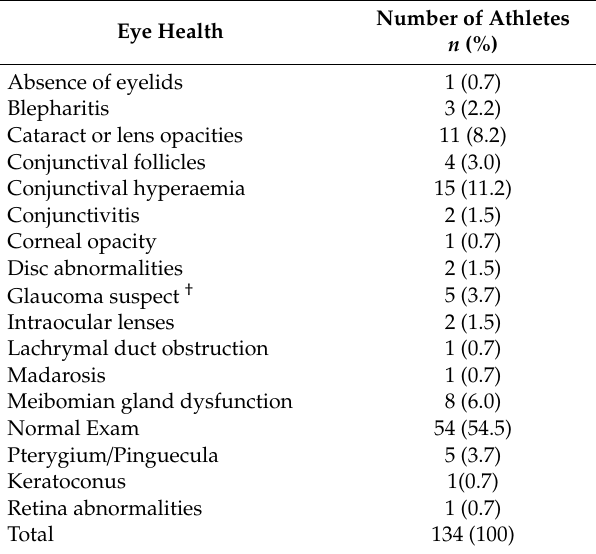
Table 6. Abnormalities observed on anterior and posterior segment